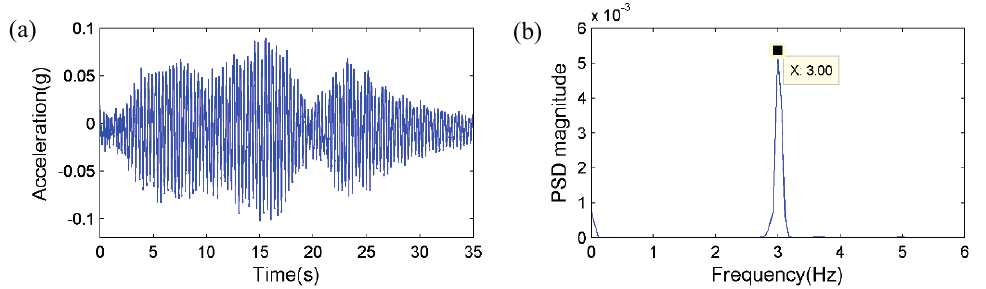
Figure 17. Jumping of pedestrians: ( a ) Displacement by the vision sensor; ( b ) Corresponding PSD.